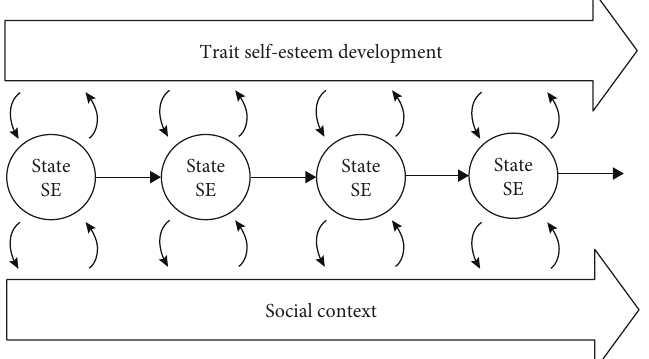
Figure 2: Two forces acting upon state self-esteem (SE): self-esteem attractors have a degree of constraint on state self-esteem variability, and the immediate social context can perturb state self-esteem variability (adapted from